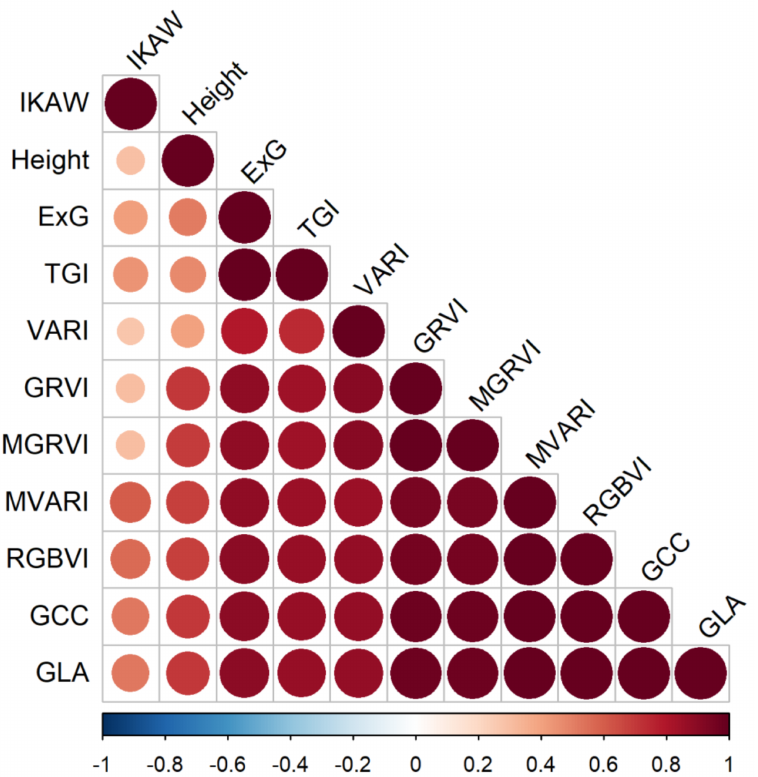
Figure 7. Visualization of the correlation matrix for all 10 RGB vegetation indices and canopy